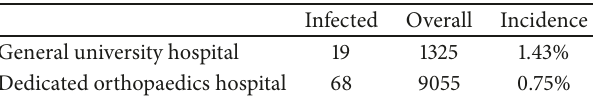
Table 1: Overall incidence rates decreased at dedicated orthopaedics hospital. Overall incidence rate of PJIs between the general univer- sity hospital and dedicated orthopaedics hospital. p = .0224 by X 2 analysis.